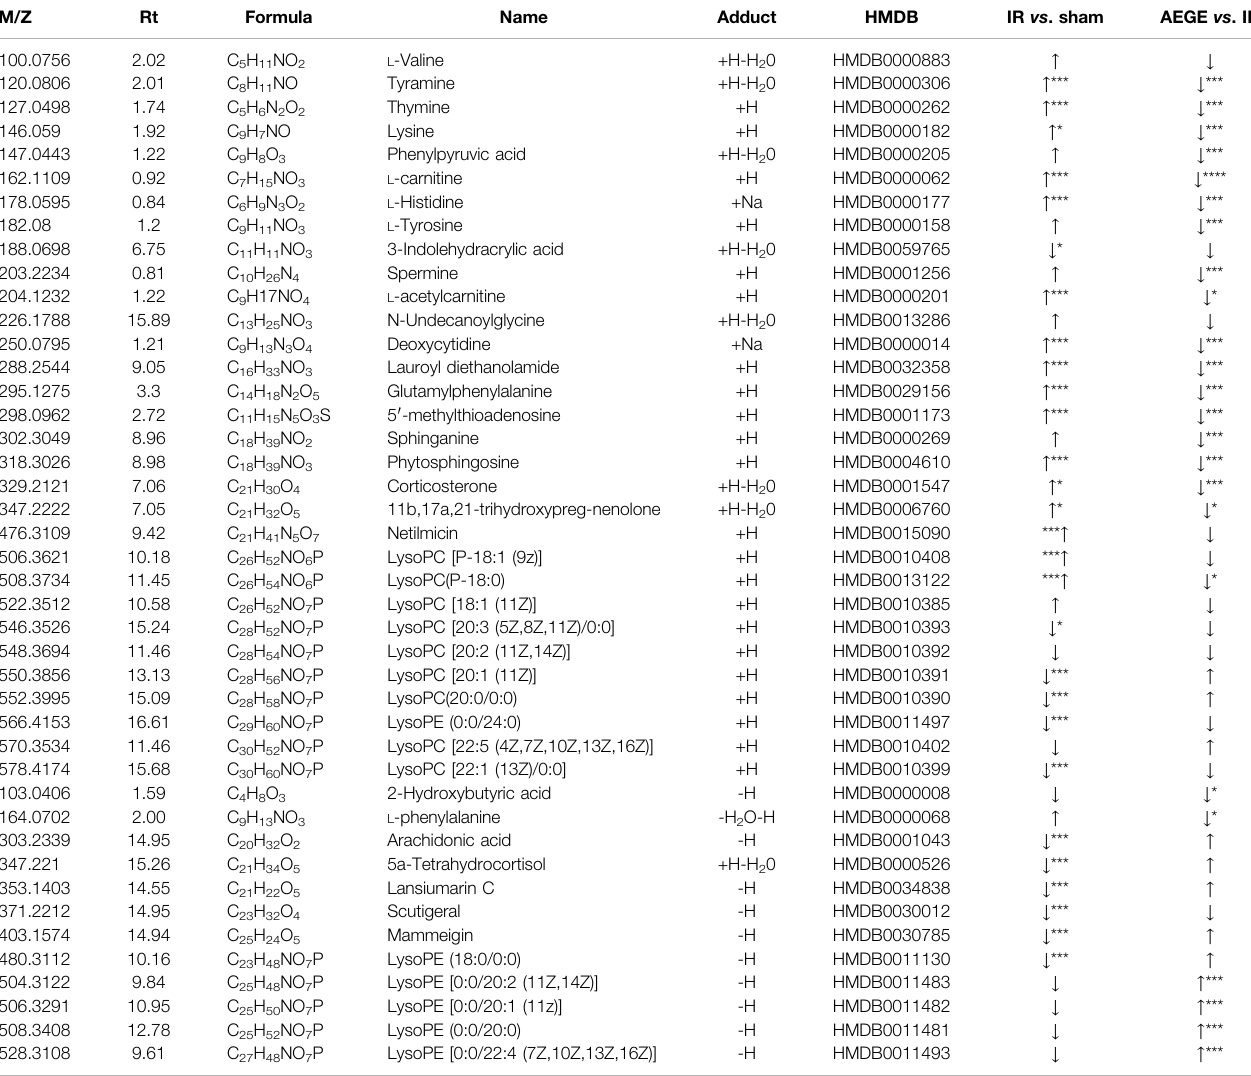
TABLE 1 | Potential biomarkers of cerebral ischemic injury post-treatment with AEGE. M/Z Rt Formula Name